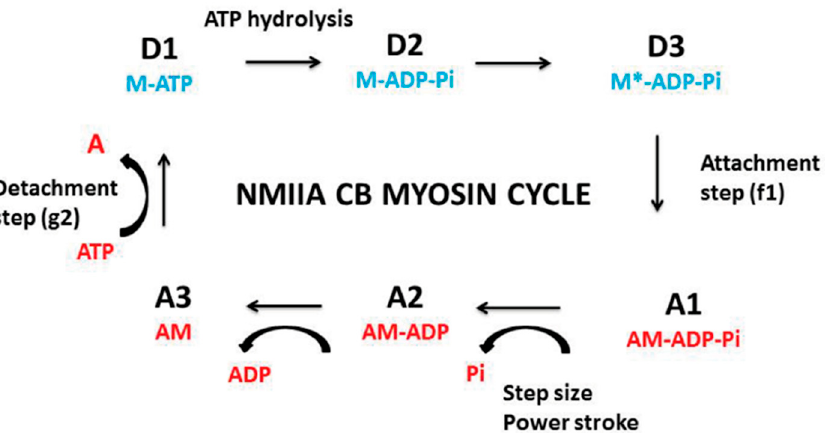
Figure 1. Crossbridge NMIIA cycle . The NMIIA CB cycle is composed of six main successive con- formational steps, of which three are detached (D1, D2, and D3) and three are attach ed (A1, A2, and